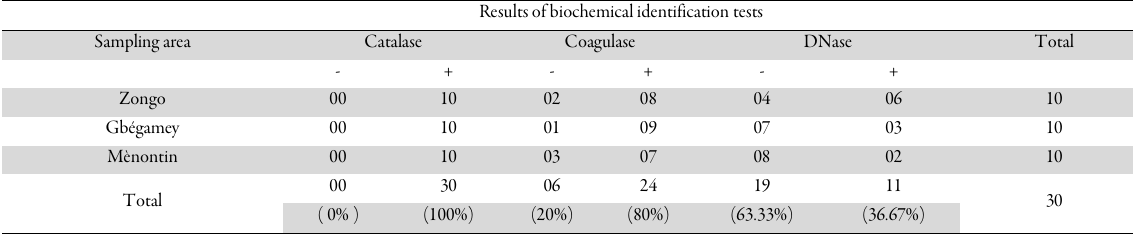
Table 2. Results of biochemical identification tests for Staphylococci